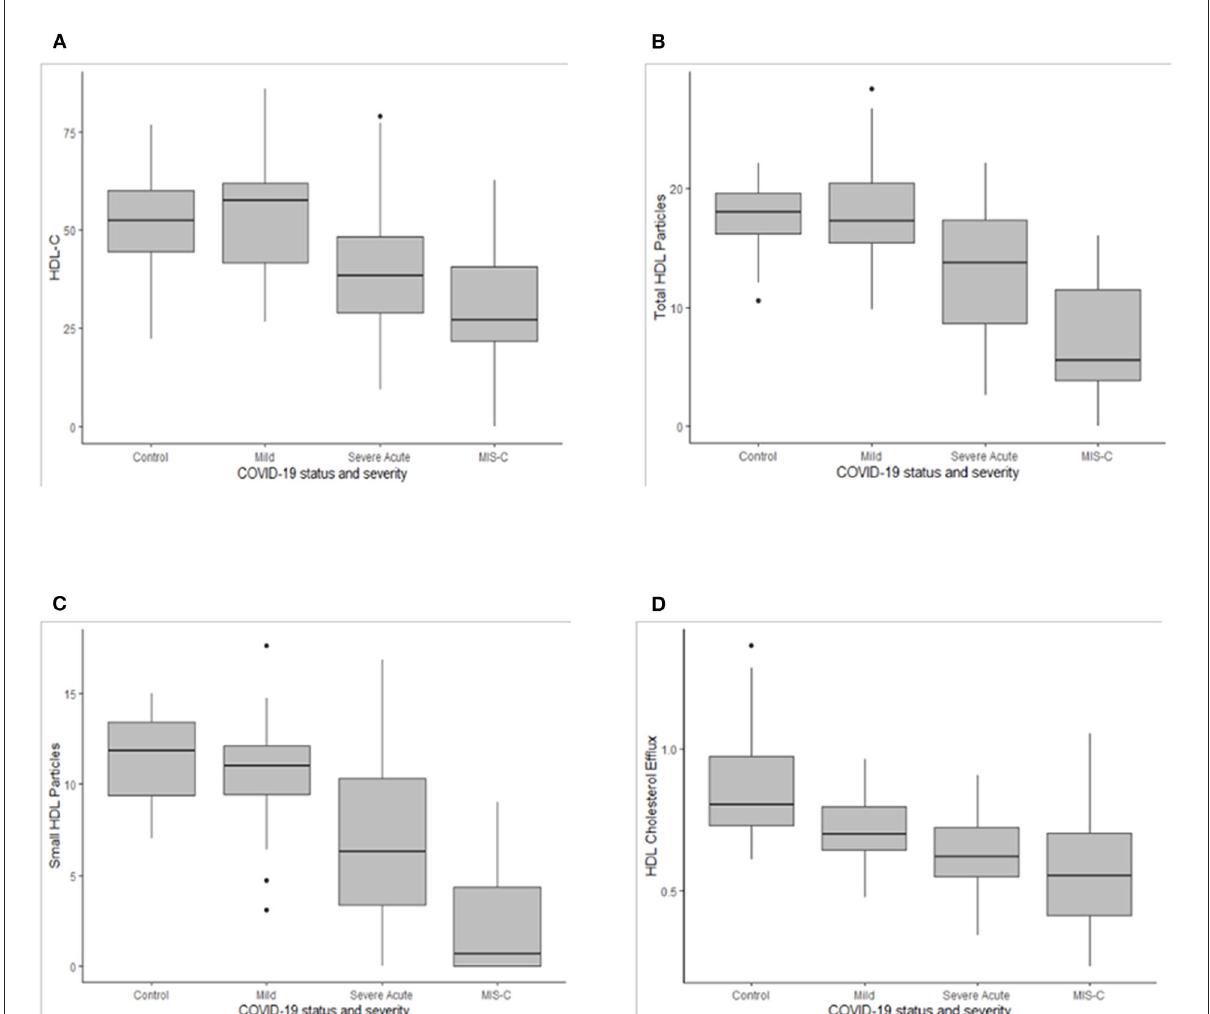
FIGURE1 Box plots for high density lipoprotein cholesterol [HDL-c, (A) ], total HDL particles (B) , small HDL particles (C) , and the HDL cholesterol efflux (D) . Medians are depicted as horizontal black lines, interquartile ranges within the shaded boxes, and ranges as vertical lines for the COVID-19 negative group (Control) and for COVID-19 positive groups with mild or no symptoms (Mild), severe acute symptoms (Severe Acute) or multisystem inflammatory syndrome of children (MIS-C). Asterix depict